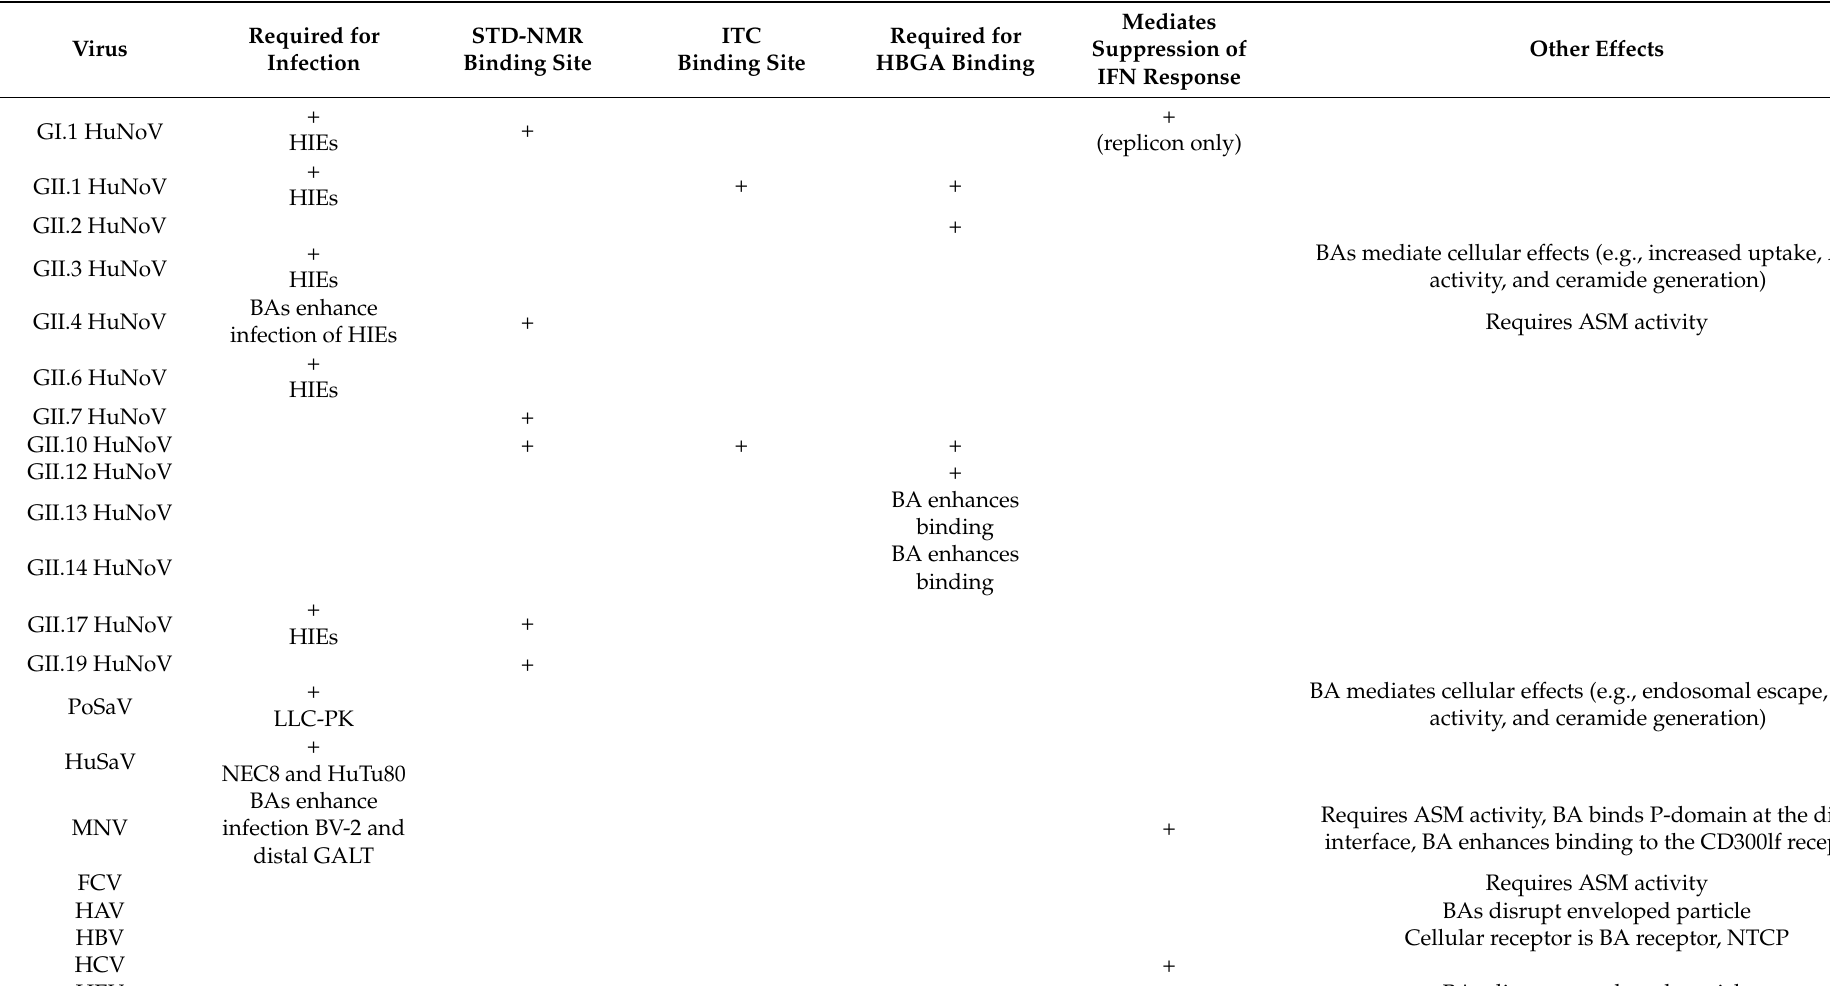
Table 3. Summary of BA effects on viral